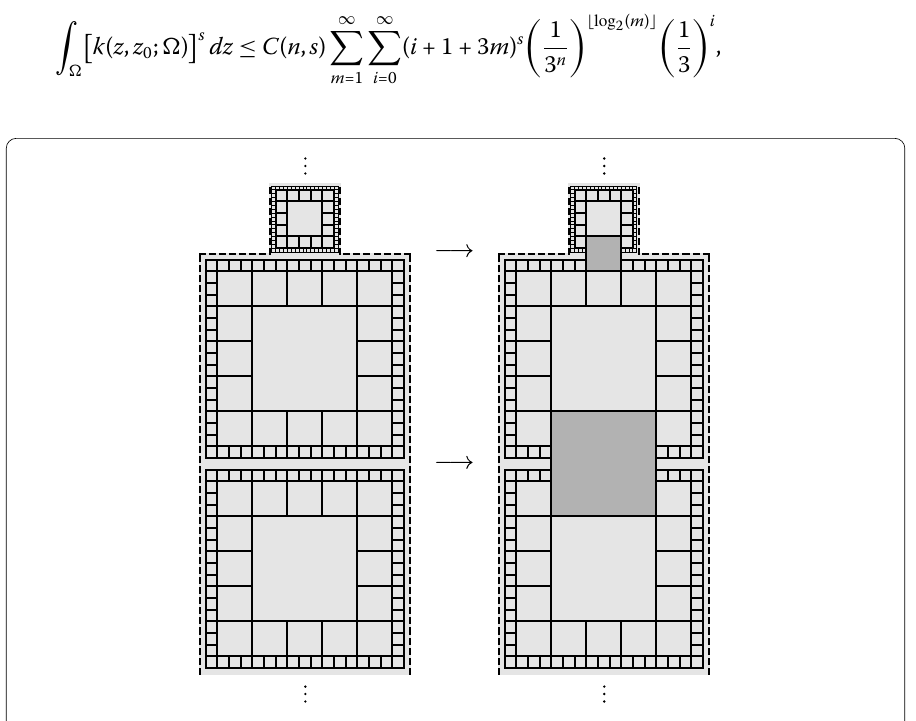
Figure 8 Modifying the subdivision. The dark gray sets replace the sets they cover so as to connect the blocks. Note that even with this modification, there are sets of measure zero at the boundary of each (cid:2) i that do not get